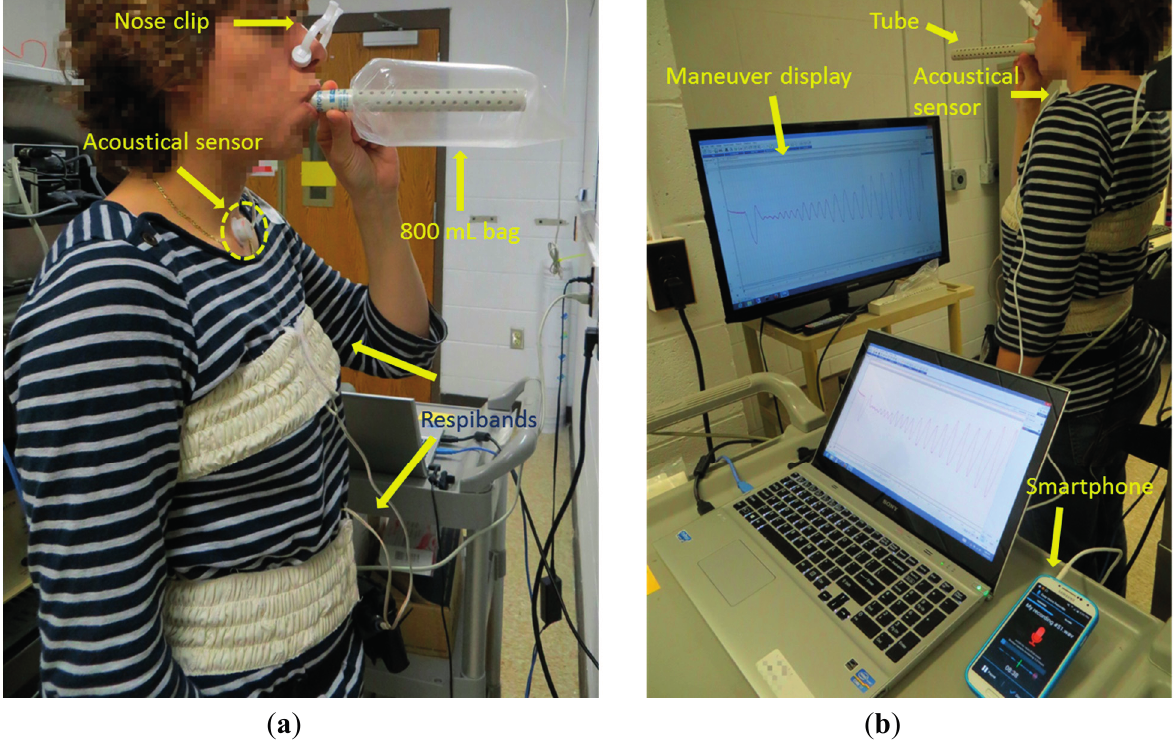
Figure 1. Simultaneous recordings of the tracheal sound (using a smartphone) and the volume signal (using Respibands). ( a ) The participant is breathing through 800 mL bag; ( b ) The participant is breathing through a tube while performing the respiratory